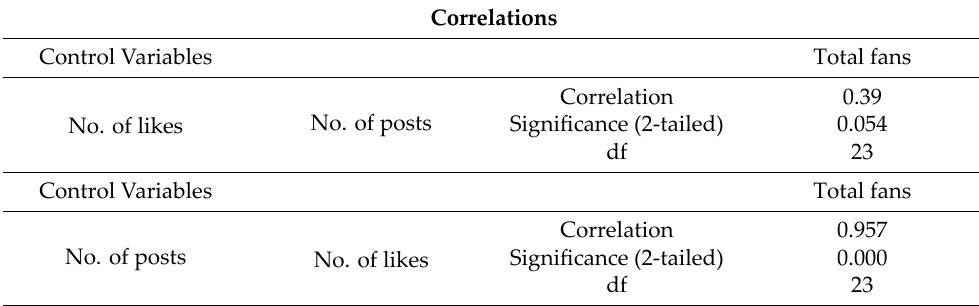
Figure 1. Breakdown of video topics in each public library. Table 8. Partial correlation analysis of the number of fans, posts, and likes (as of 5 May Table 6. Topic categorization of video from April 2022.